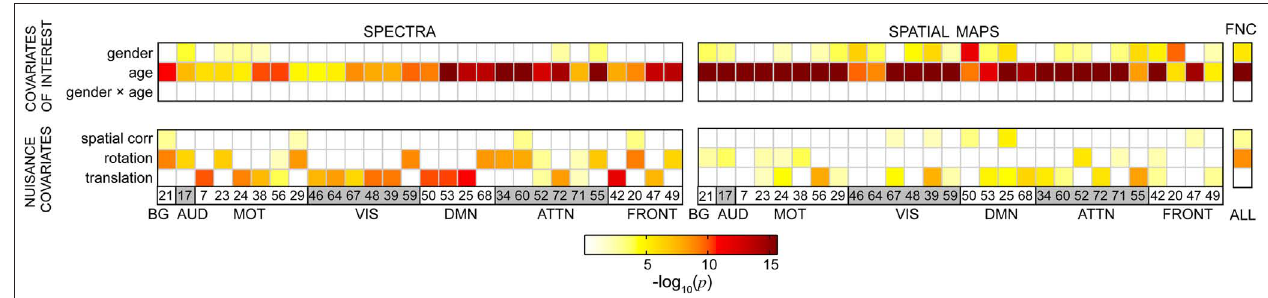
FIGuRe 5 | Results from the reduced MANCoVA models, depicting the significance of covariates of interest (top) and nuisance predictors (bottom) for power spectra (left), SMs (middle), and the FNC matrix (right) in log units. White cells indicate terms that were removed from the full model